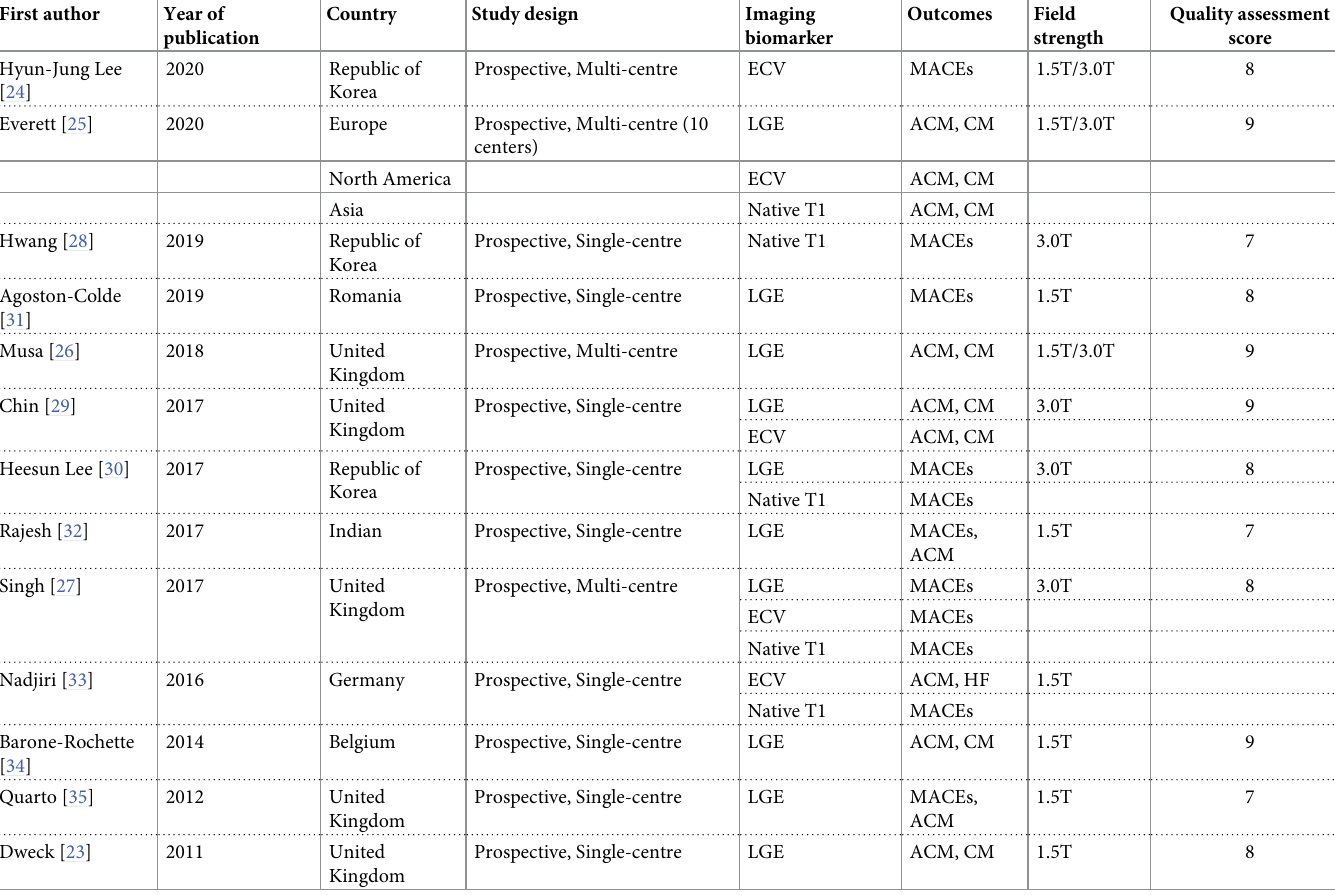
Table 2. Baseline characteristics of the studies included in the